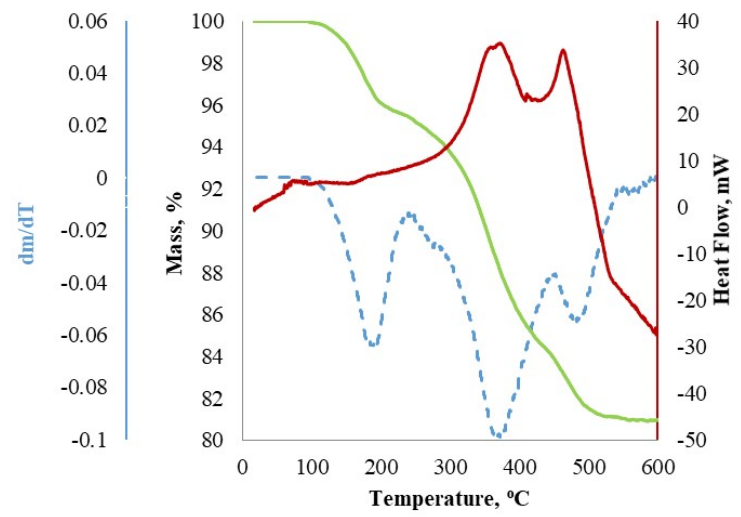
Figure 5. DSC/TGA and DTG curves.